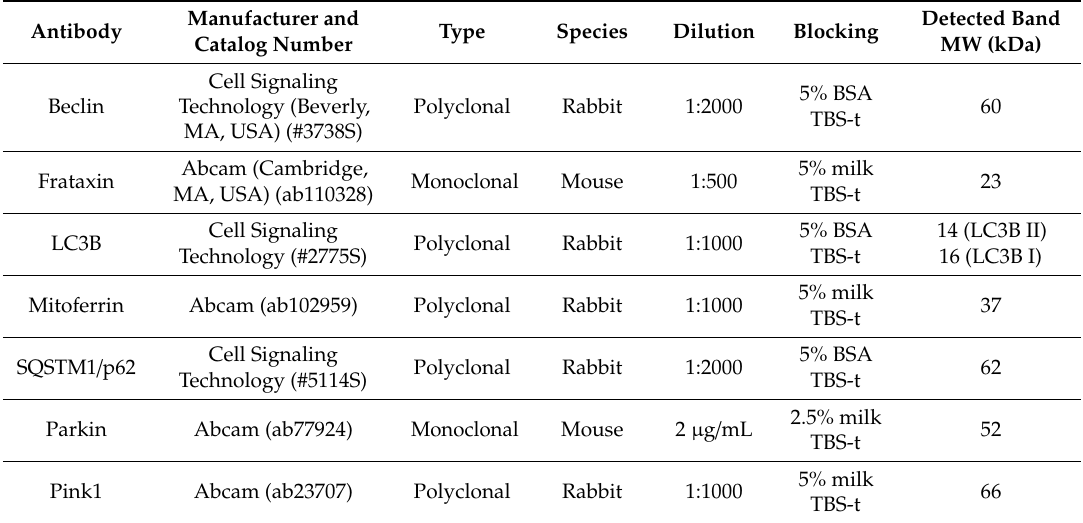
Table 1. Technical specifications of the primary antibodies used for Western